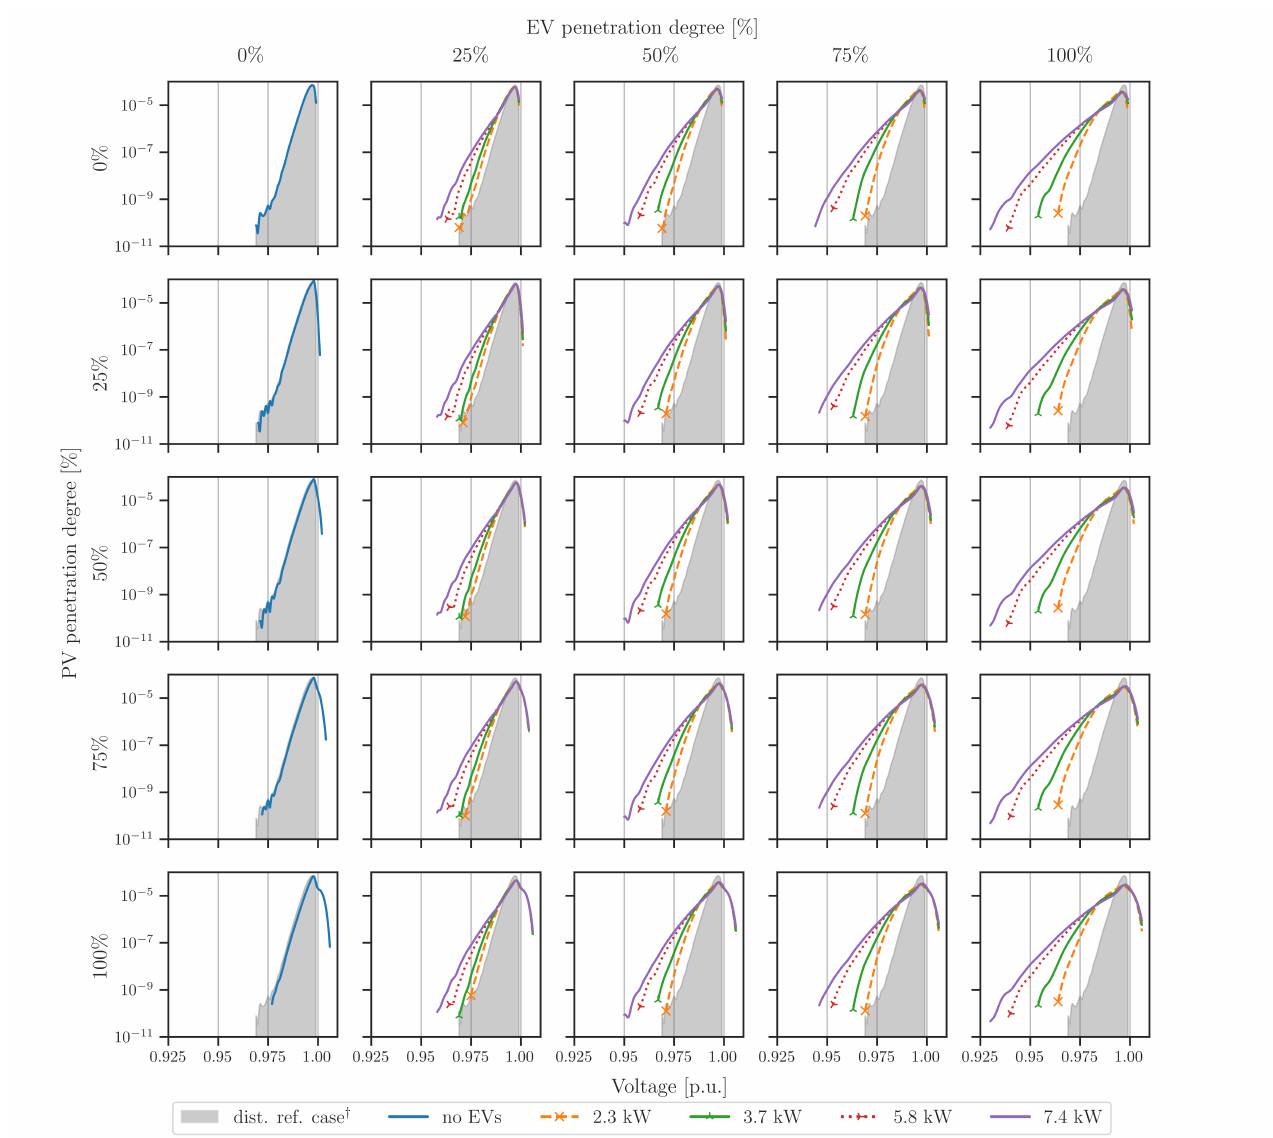
Figure 3. Gaussian distribution of the voltage profiles for different EV and PV levels at various charging rates; † the grey shaded zone denotes the 0% EV and 0% PV